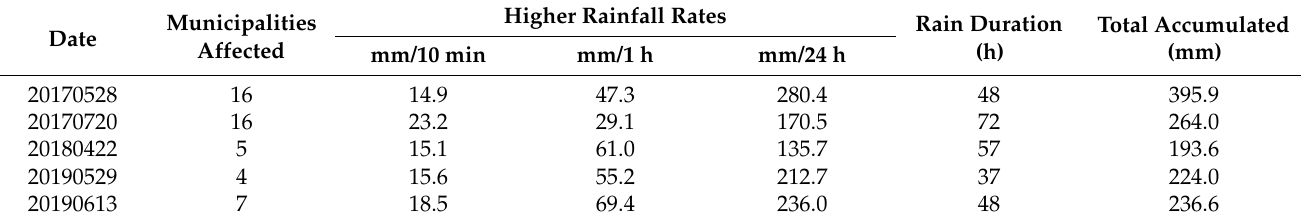
Table 1. Characteristics of the severe rainfall events